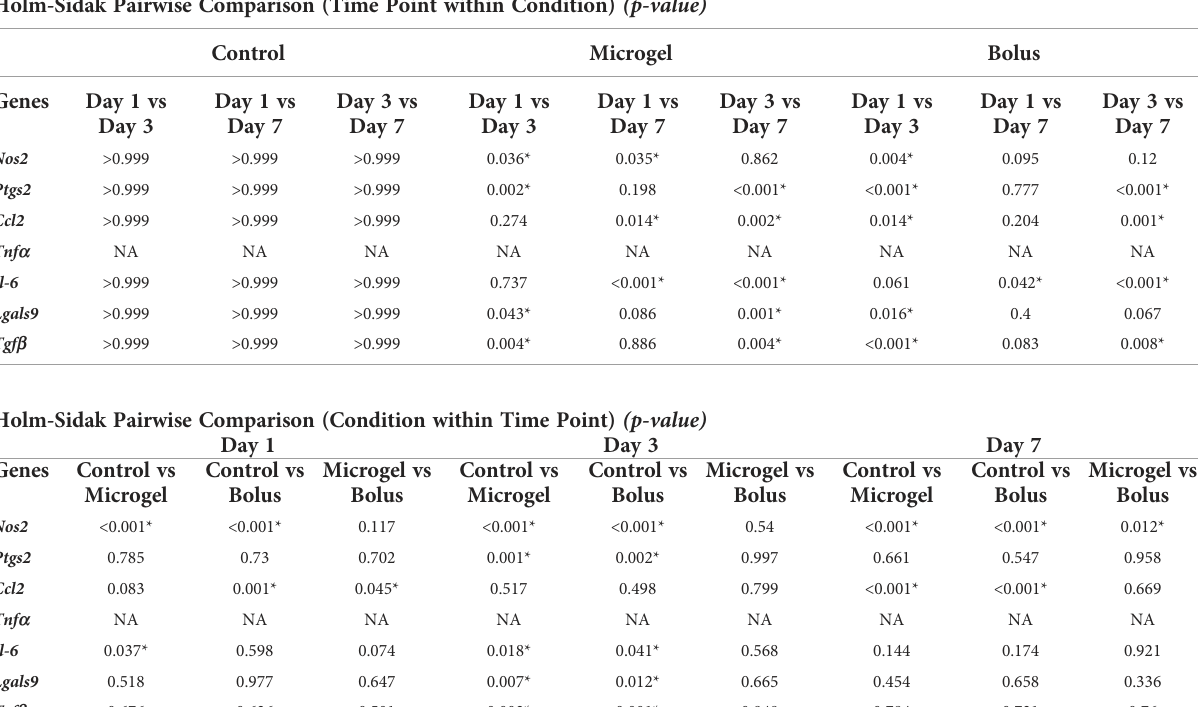
TABLE 4 Pairwise comparison of all Time Points within Conditions and all Conditions within Time